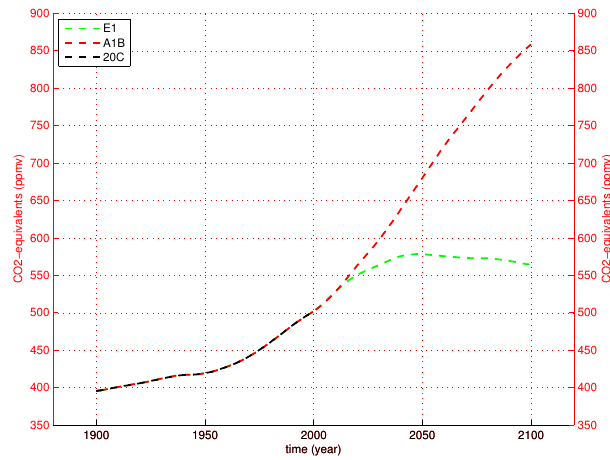
Fig. 1. Evolution of the prescribed greenhouse gases expressed as a concentration of CO 2 equivalents (ppmv) for the historical observed period 1900–2000 (20C; black curve) and the two future scenarios. A1B (red) is the IPCC SRES marker scenario. E1 (green) is the mitigation scenario produced by the IMAGE integrated assessment model.